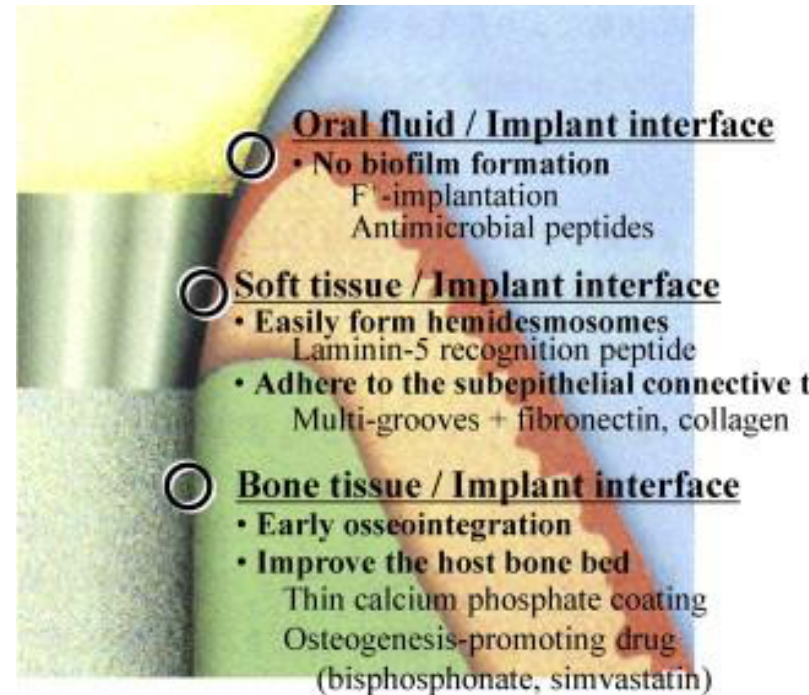
Figure 7. Presentation of various models showing antimicrobial activity of AMP: ( a ) Barrel-stave model, ( b ) carpet model, and ( c ) toroidal model [264]. Reprinted with permission from [264]. Copyright 2016 Elsevier.